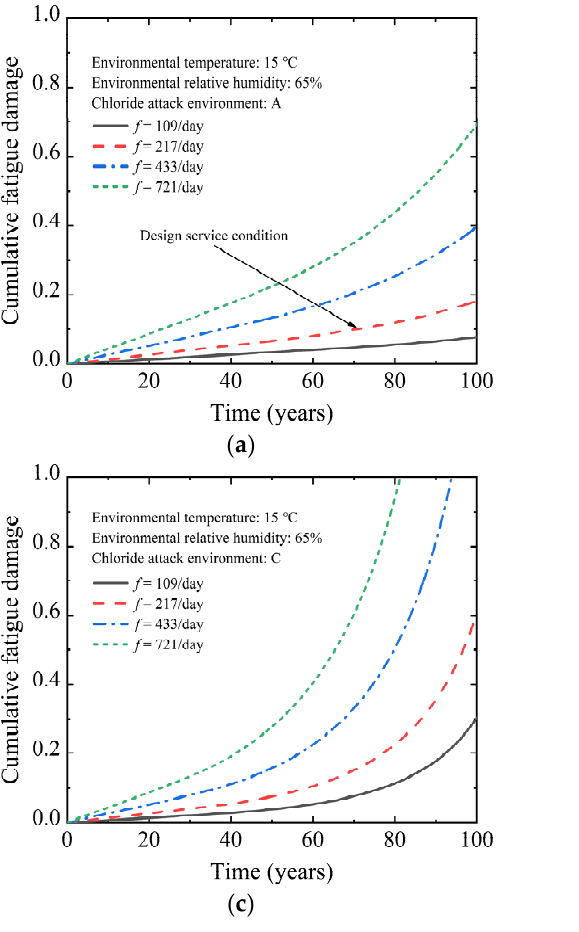
Figure 7. Cumulative fatigue damage of U-shaped beam under different chloride attack environ- ments: ( a ) A chloride attack environment; ( b ) B chloride attack environment; ( c ) C chloride attack environment; ( d ) D chloride attack environment.